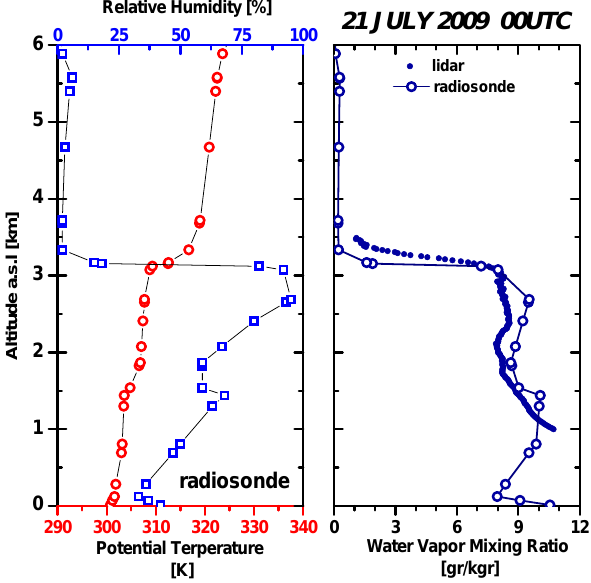
Fig. 6. Potential temperature (K) and relative humidity-RH (%) vertical profiles obtained from radiosonde data on 21 July 2009 (00:00UTC) (left) and water vapor mixing ratio derived from Ra- man lidar measurements on 21 July 2009